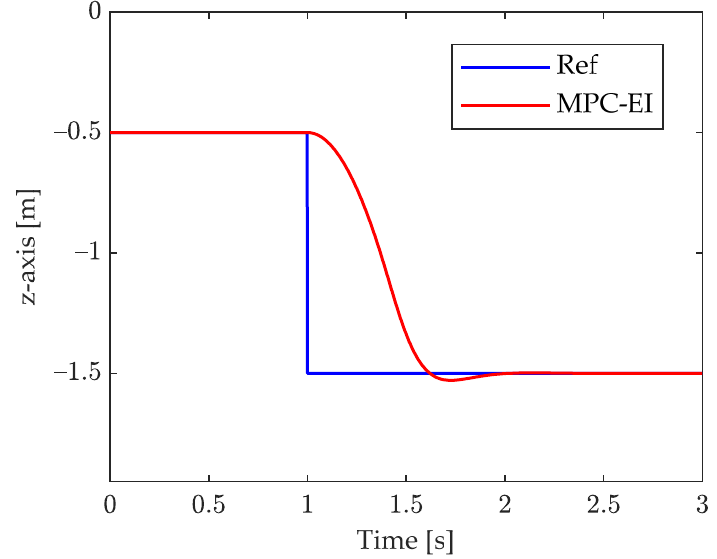
Figure 2. Tracking response with the position step reference.